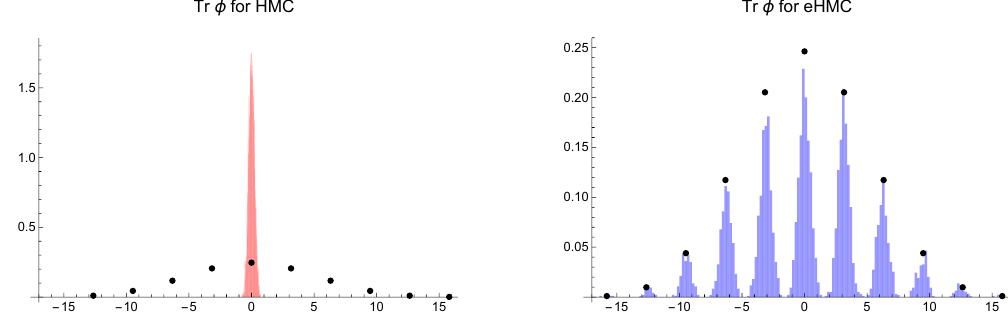
Figure 3 . Probability distribution of Tr Φ obtained from simulations with the action (2.1) with N = 10 , b = − 5 and c = 1 . It shows Tr Φ for approximately 5000 different configurations. The black points show the binomial probability of having k of N eigenvalues in the same well, their positions have been shifted to mark their corresponding positions. We can see that the eHMC was able to visit all accessible vacua with corresponding